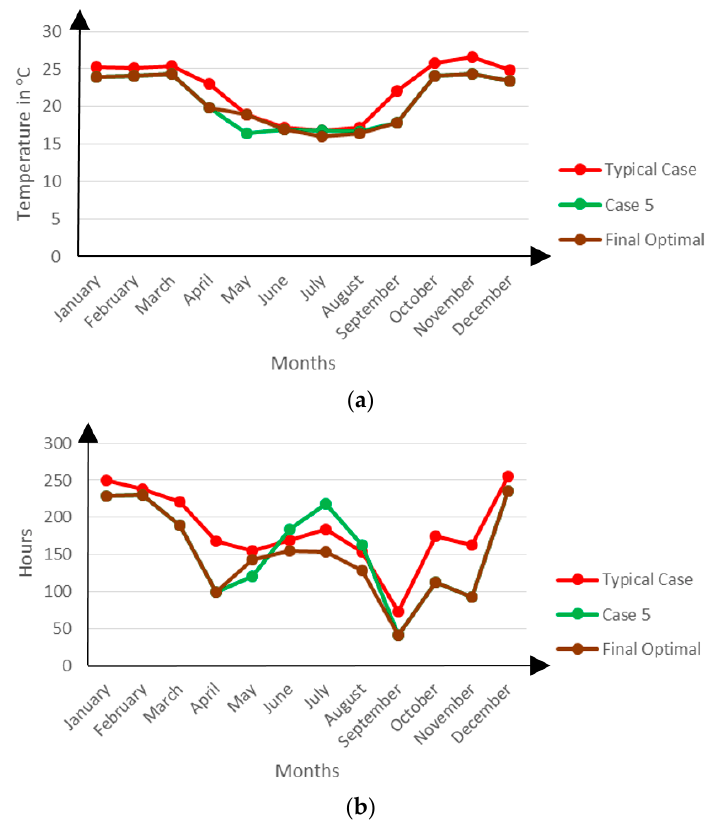
Figure 21. Monthly mean zonal temperatures ( a ), discomfort hours ( b ) for typical case, Case 5 and final optimal